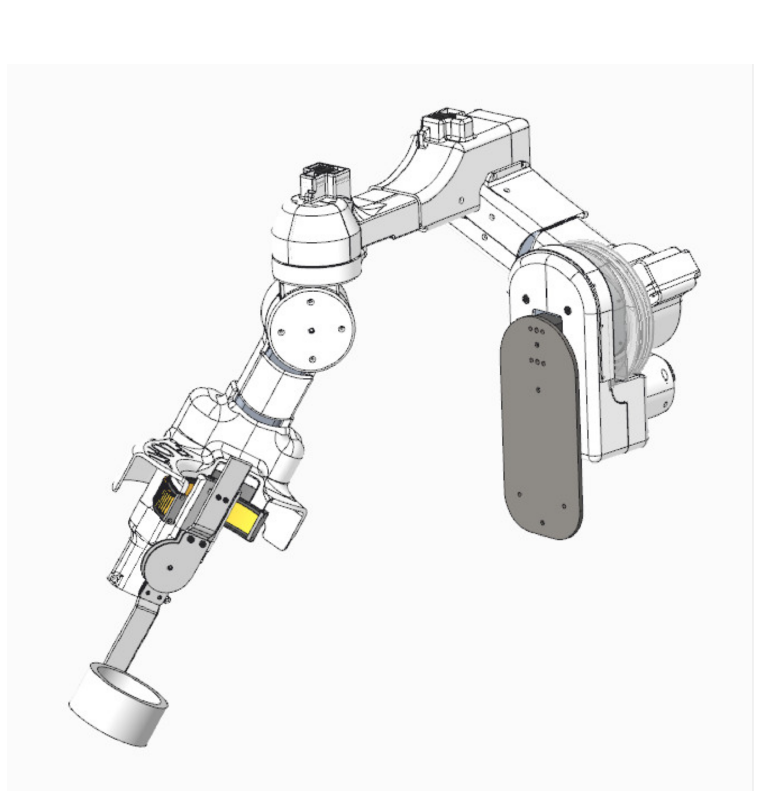
Figure 11. Float exoskeleton resting